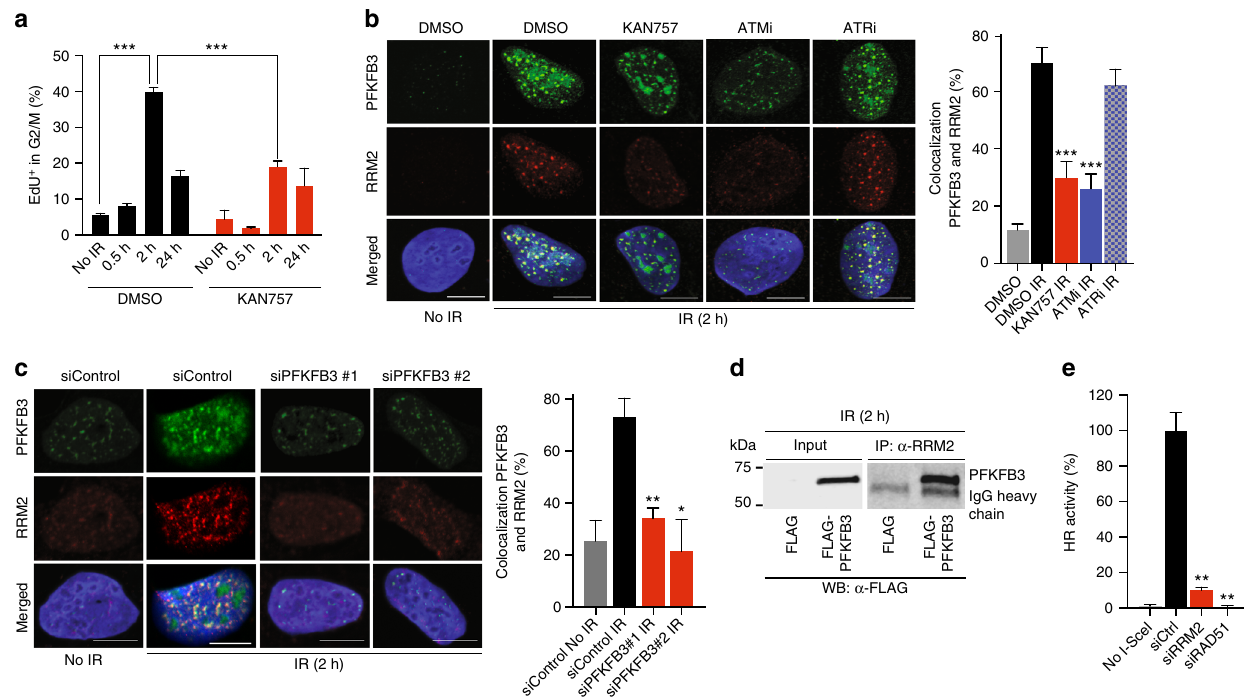
Fig. 5 PFKFB3 kinase activity supports DNA repair synthesis. a U2OS cells were treated with DMSO or 10 μ M KAN757 (6 h), exposed to IR (6 Gy, 0.5 h, 2 h, and 24 h recovery), or left untreated. At each time-point, cells were pulsed 30 min with 10 µ M EdU, harvested, and fi xed. DNA was stained with Hoechst and EdU detected by fl uorophore conjugation for fl ow cytometry analysis. Bars indicate the number of EdU-positive cells in the G2/M phase. Data are displayed as means ± SEM, n = 3. *** P < 0.001; one-way ANOVA analysis. KAN757 = KAN0438757. b Representative images of confocal analysis of IR-induced foci of PFKFB3 and RRM2 in U2OS cells following treatments (6 h) as indicated, subjected to IR (6 Gy, 2 h recovery), or left untreated. Bar chart on the right shows the percentage of cells with PFKFB3 foci co-localizing with RRM2 foci (>10 colocalizing foci/cell), >100 cells/condition. Data are displayed as means ± SEM, n = 2. *** P < 0.001; one-way ANOVA analysis. KAN757 = KAN0438757. c Confocal analysis of RRM2 and PFKFB3 recruitment upon IR (6 Gy, 2 h recovery) in U2OS cells treated with indicated siRNA for 24 h or left untreated. To the right, bar chart showing quanti fi cation of cells with PFKFB3 foci co-localizing with RRM2 foci (>10 colocalizing foci/cell), >100 cells/condition. Data are displayed as means ± SEM, n = 2. ** P < 0.01, * P < 0.05; one-way ANOVA analysis. d FLAG-PFKFB3 or FLAG transfected U2OS cells were exposed to IR (6 Gy) or left untreated. At 2 h post-IR cells were subjected to immunoprecipitations followed by immunoblot with FLAG antibody. Shown is a representative experiment of n = 3. e HR activity after treatment of U2OS DR-GFP cells with indicated siRNAs as assessed by FACS analysis, whereby the siControl cells are set as reference cells (100% activity). Data are displayed as mean ± SEM, n = 3. ** P < 0.01; one-way ANOVA